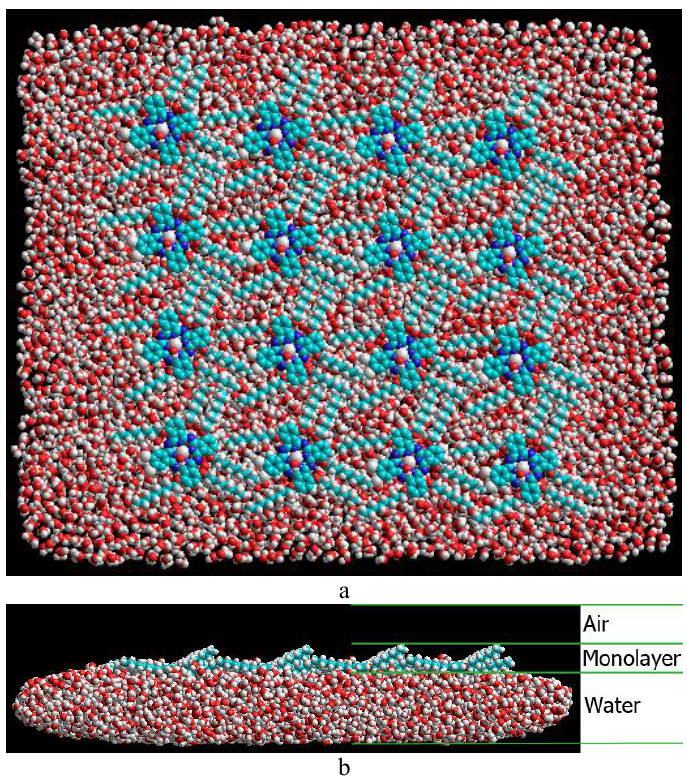
Fig. 2. Model of floating monolayer packing of compound III placed on the water surface before the lateral substituents were displaced from the macrocycle plane: a) top view, b) side